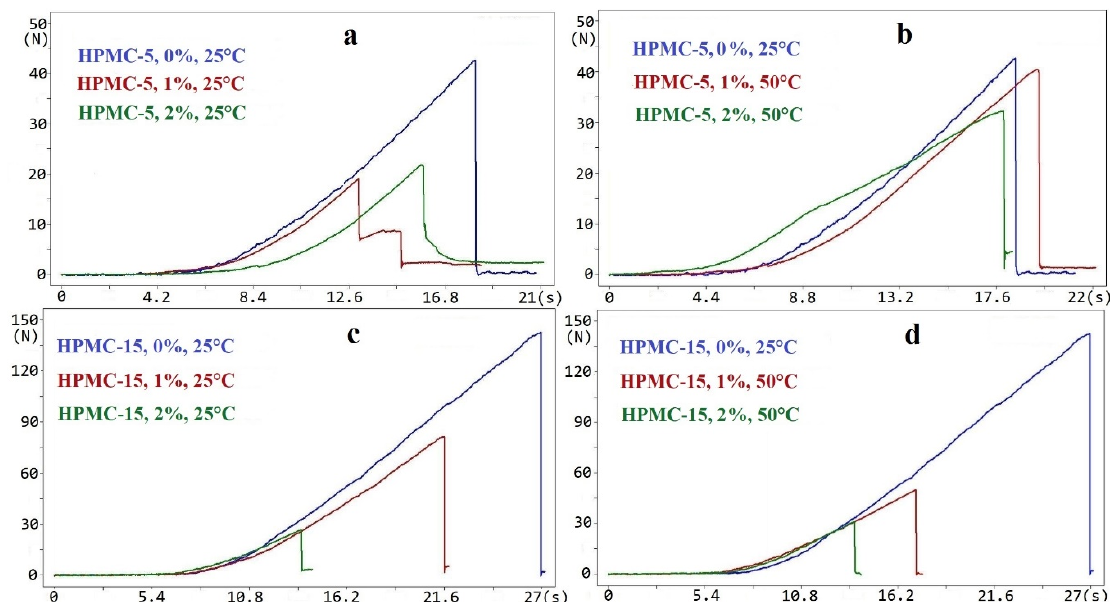
Figure 2. Deformation process in the case of HPMC and HPMC films containing SP. ( a ) HPMC-5, 25 °C; ( b ) HPMC-5, 50 °C; ( c ) HPMC-15, 25 °C; ( d ) HPMC-15, 50 °C). SP: sucrose-palmitate.